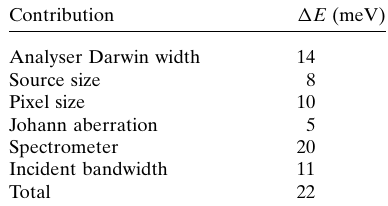
Table 1 Contributions to the energy resolution of the high-resolution spectro- meter using a 50 m m-thick PMMA